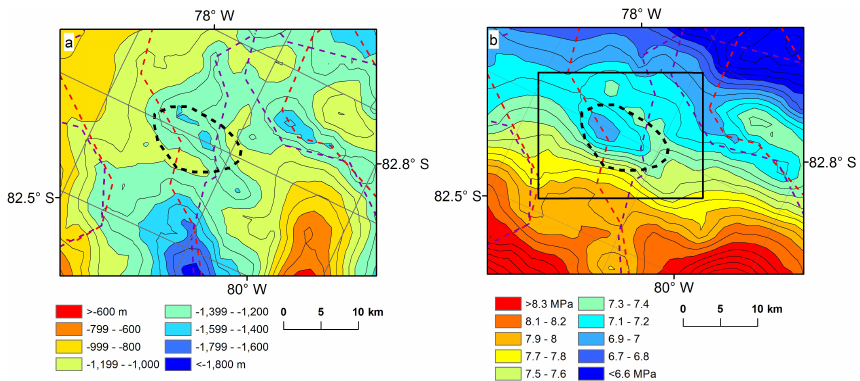
Fig. 4. Hydrological pathways (dashed lines) superimposed on (a) bed topography and (b) hydrological potential of the region surrounding Institute E2. The black box in (b) denotes the region depicted in Fig. 5. Two sets of hydrological pathways are given: red dashed lines, calculated using our aircraft ice surface altimeter data (Ross et al., 2012); and purple dashed lines, calculated using surface elevations from Bamber et al. (2009). Black dashed line delineates the approximate location of Institute E2, according to Smith et al. (2009). The direction of ice flow is predominantly from the bottom of the figures to the top.